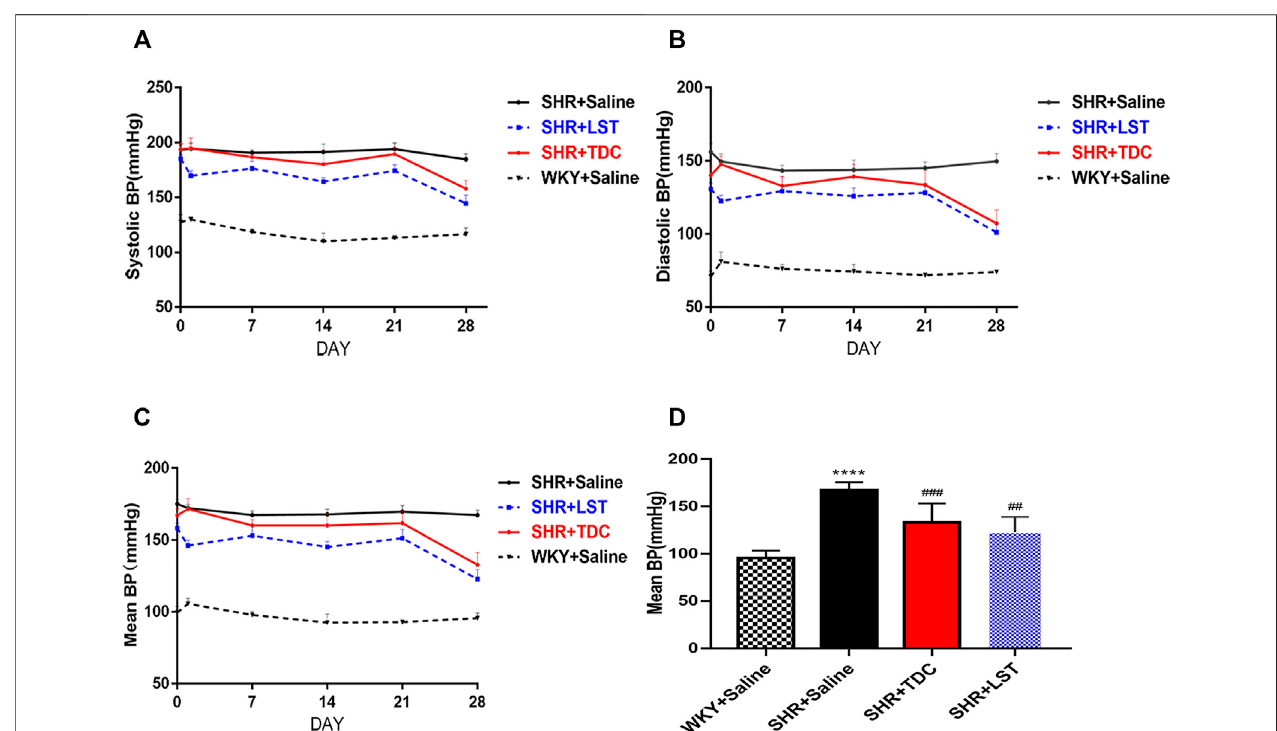
FIGURE 2 | Effects of TDC on noninvasive blood pressure in SHR (A – C) Representative data plots of SBP, DBP, and MBP measurements, respectively, over 4 weeksusingthenoninvasivetail-cuffmethodinconsciousrats (D) BargraphcomparisonoftheMBPinthefourratgroupsatday28.Dataareexpressedasmean ± SD, n (cid:1) 5 – 6. ****p < 0.0001 vs. WKY rats; ##p < 0.01, ###p < 0.001 vs. SHR. >